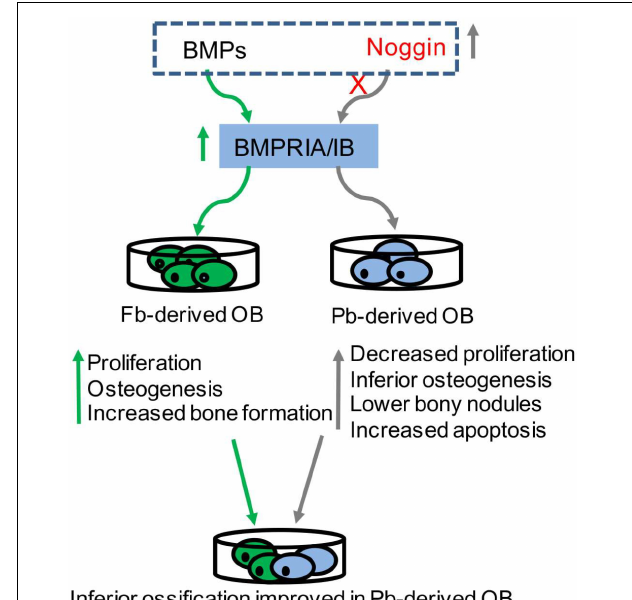
FIGURE 1 | BMP signaling in tissue-derived osteoblasts. BMPRs (BMPRIA/IB) were highly expressed in neural-crest-derived frontal osteoblasts (Fb-derived OB) (green in arrow), which exhibited increased proliferation, and osteogenesis and bone formation. Noggin was highly expressed in mesoderm-derived parietal osteoblasts (Pb-derived OB), which exhibited decreased proliferation, inferior osteogenesis, lower bone formation and increased apoptosis (gray in arrow). The addition of some Fb-derived OB into Pb-derived OB can significantly improve the ossification. Proper modulation of BMP signaling (dotted box) can influence the osteogenic potential in tissue-derived osteoblasts.